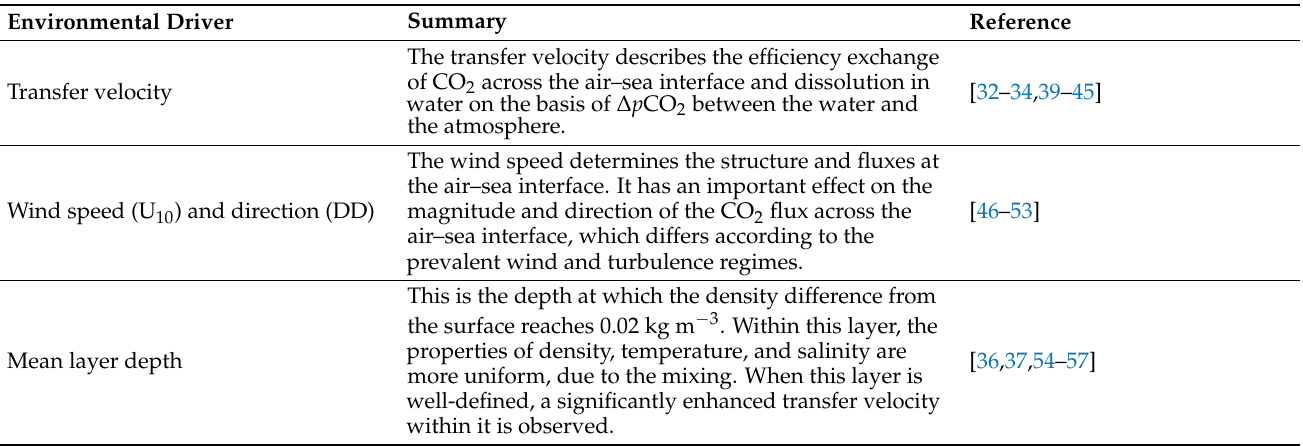
Table 3. Justification of the use of the biological and physical drivers of surface DIC, TA, and pH used for this study.